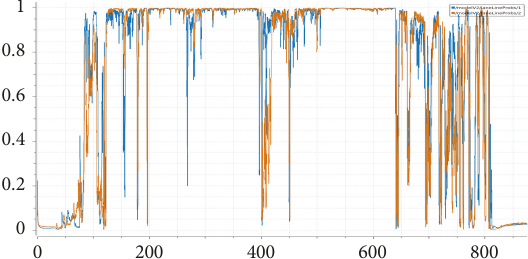
Figure 12: T1D3 left (1) and right (2) lane recognition.